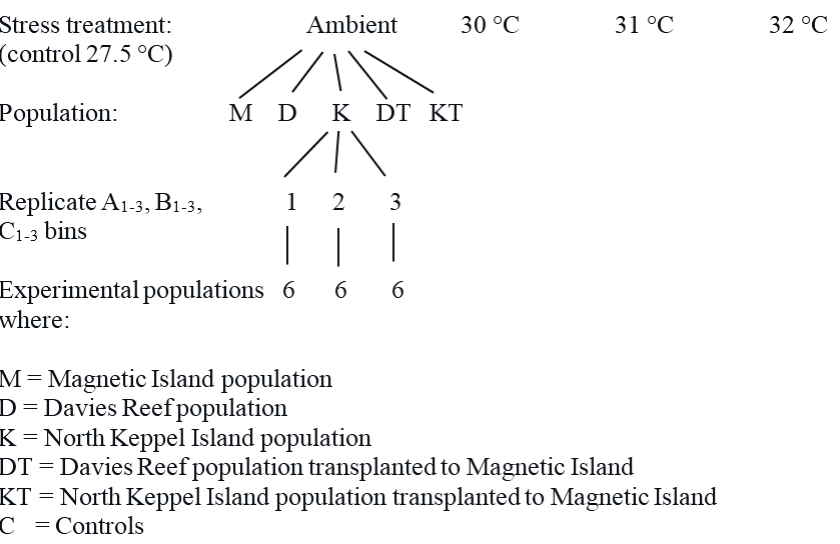
Figure 2. Experimental set-up devised by Berkelmans and van Oppen (2006) [22]. (Source Ray